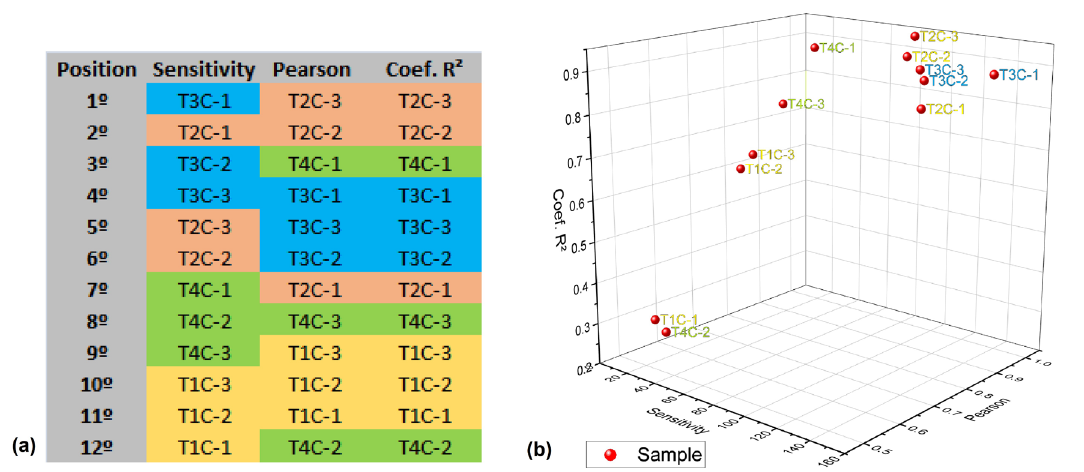
Figure 13. Ranking table of the results per sample for each analysis parameter (a); spatialization of the results of each parameter in each sample (b).